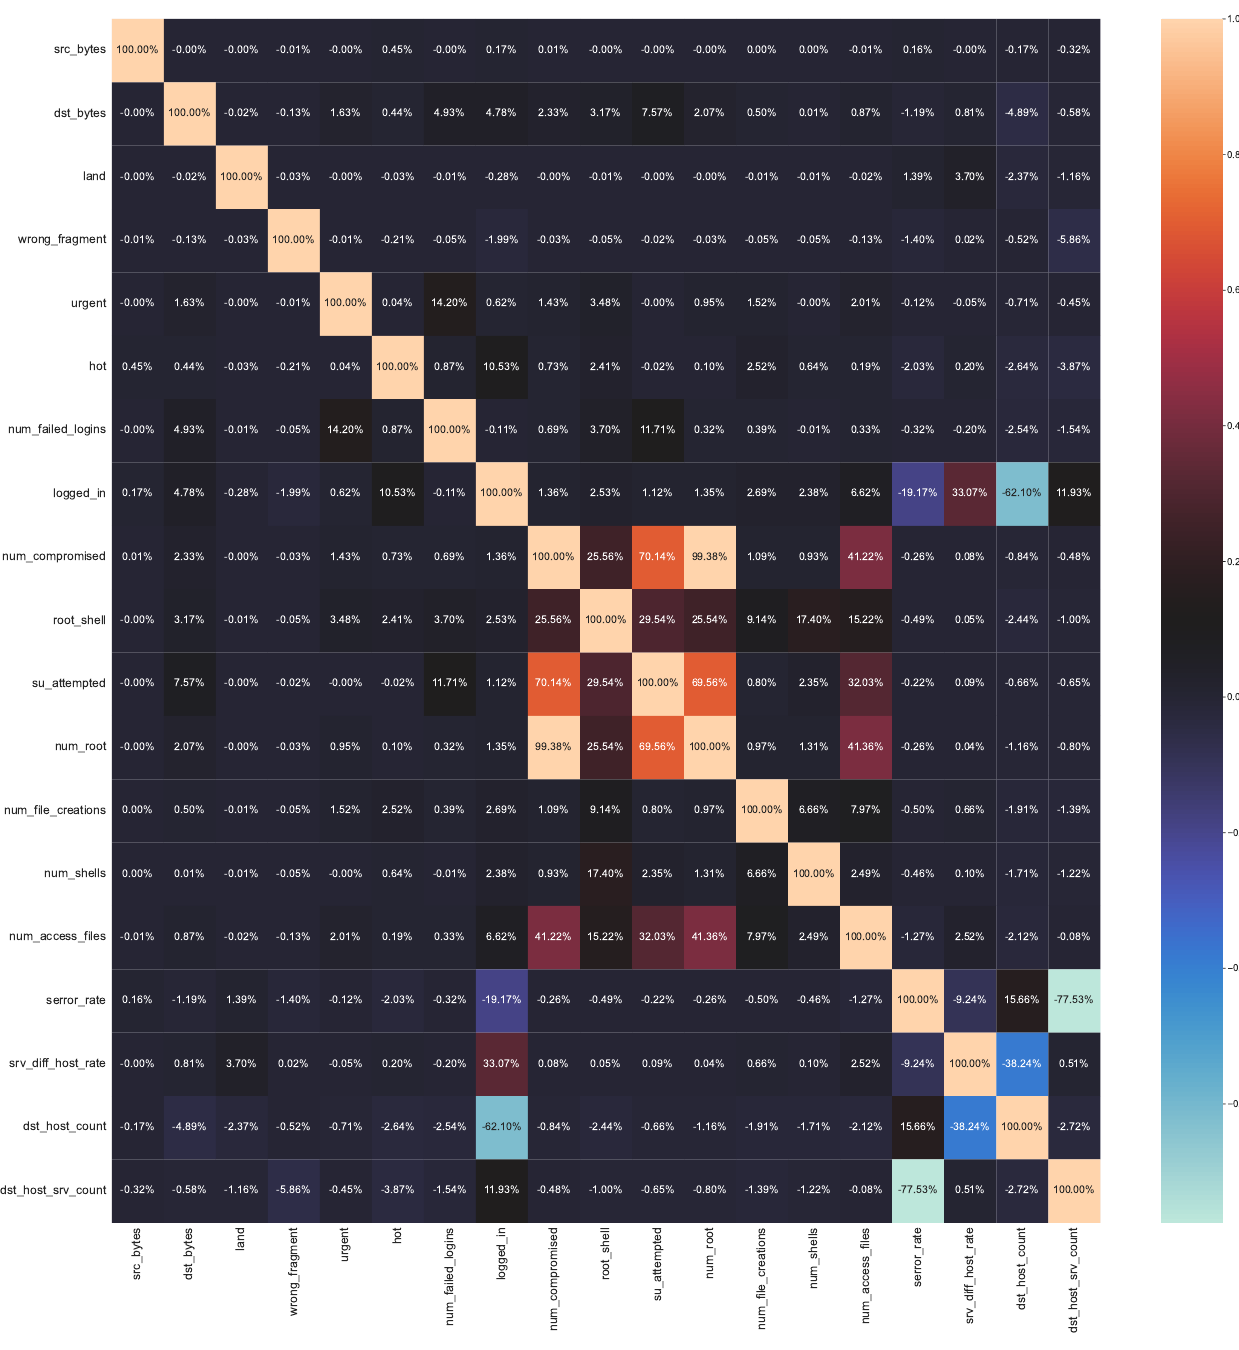
Figure 7. Selected features covariance